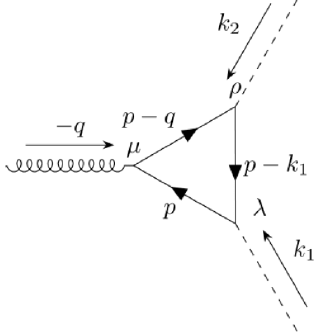
( R ) µ ( k ) 1 , k 2 µλρ